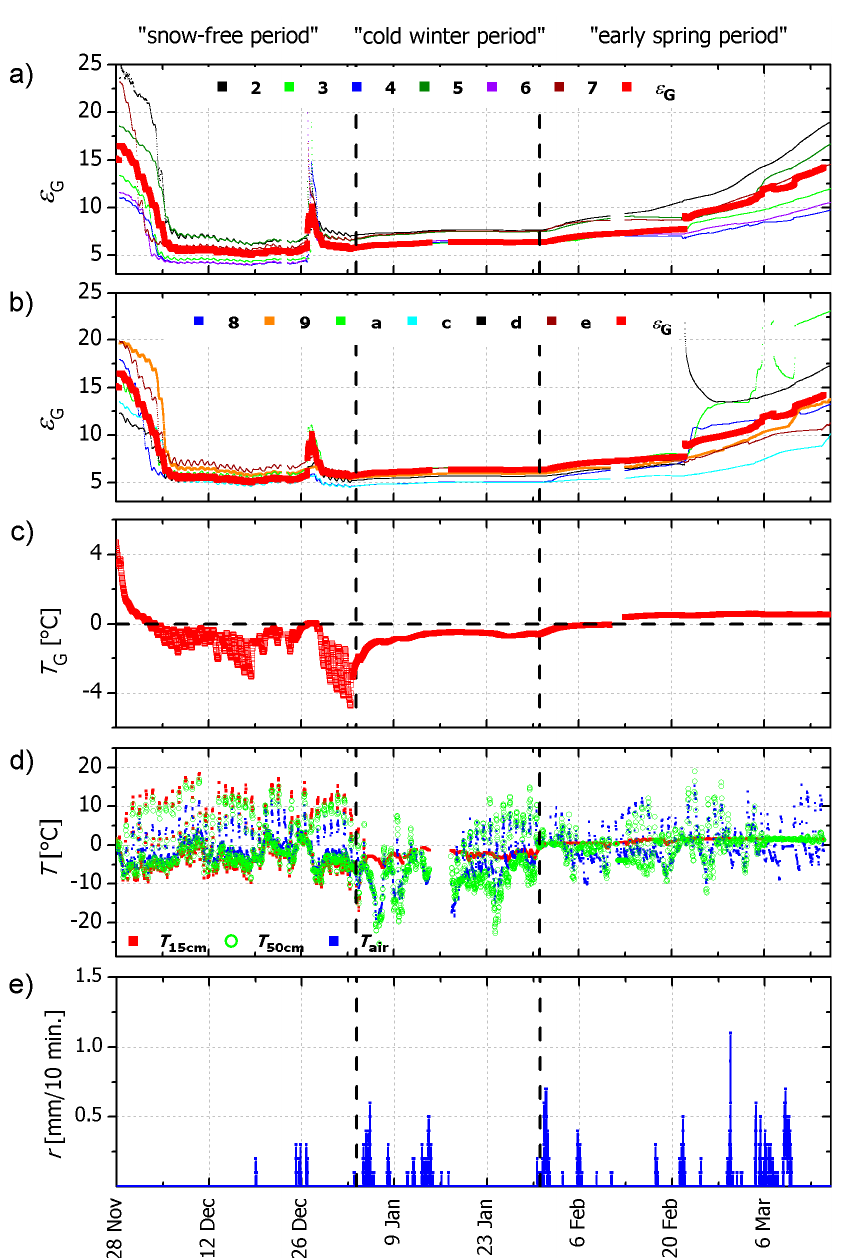
Figure 4. Panels ( a , b ) show the time series of in-situ measured ε G along transects 1 and 2 (shown in Figure 1), respectively. Panel ( c ) shows the average ground temperature T G measured by the 12 SMT-100 sensors along transects 1 and 2. Panel ( d ) indicates temperatures T air , T 15 cm , and T 50 cm measured by ELBARA-II’s PT-100 temperature sensor and SMT-100 sensors placed 15 cm and 50 cm above ground, respectively. Panel ( e ) shows the recorded precipitation (both rain and snow) in units of mm/10 min. over the entire